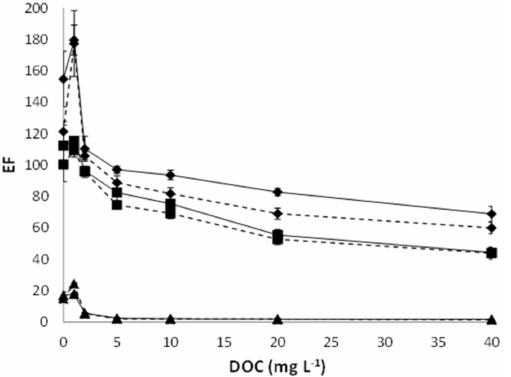
Figure 3. Variation of EF against DOC concentration in samples for the three evaluated hollow fiber types: (cid:7) Accurel PP 50 / 280, (cid:4) Accurel PP Q3 / 2, and (cid:78) Accurel PP S6 / 2. Time of extraction 120 min. Dotted line represents 20 µ L acceptor solution and Solid line represents 40 µ L acceptor solution